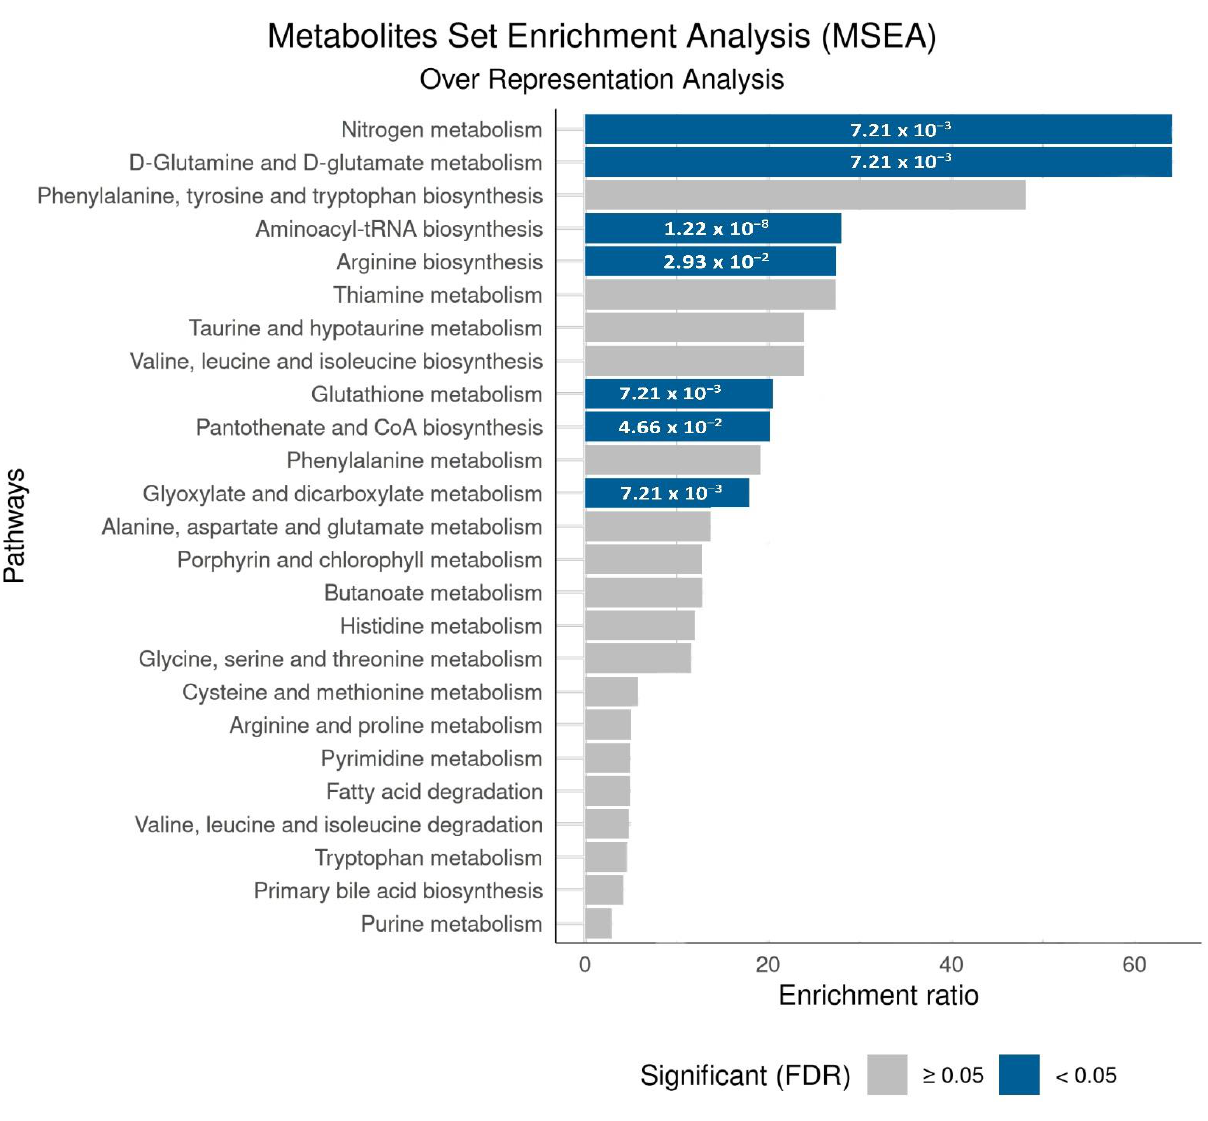
Figure 4. Metabolite enrichment analysis via over representation analysis for the discriminatory analytes found by Lasso analysis. A set of human metabolites from the KEGG library was used, and the p -adjusted values for the pathways are presented by the color bar, with the significant ones (FDR < 0.05) displayed numerically.